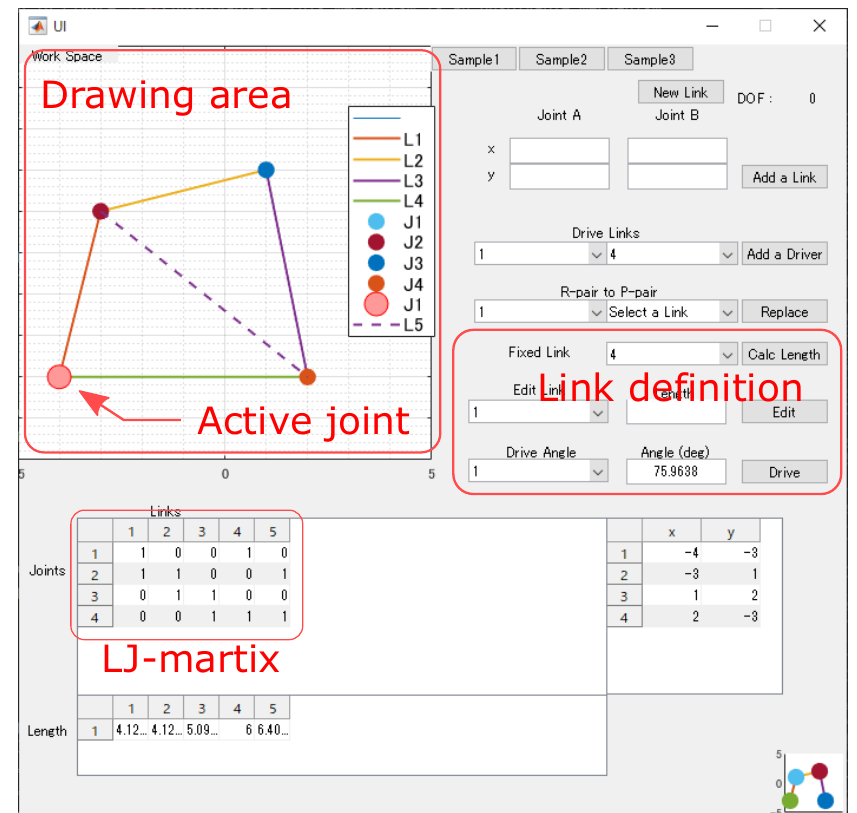
Figure 10. GUI for LJ-matrix